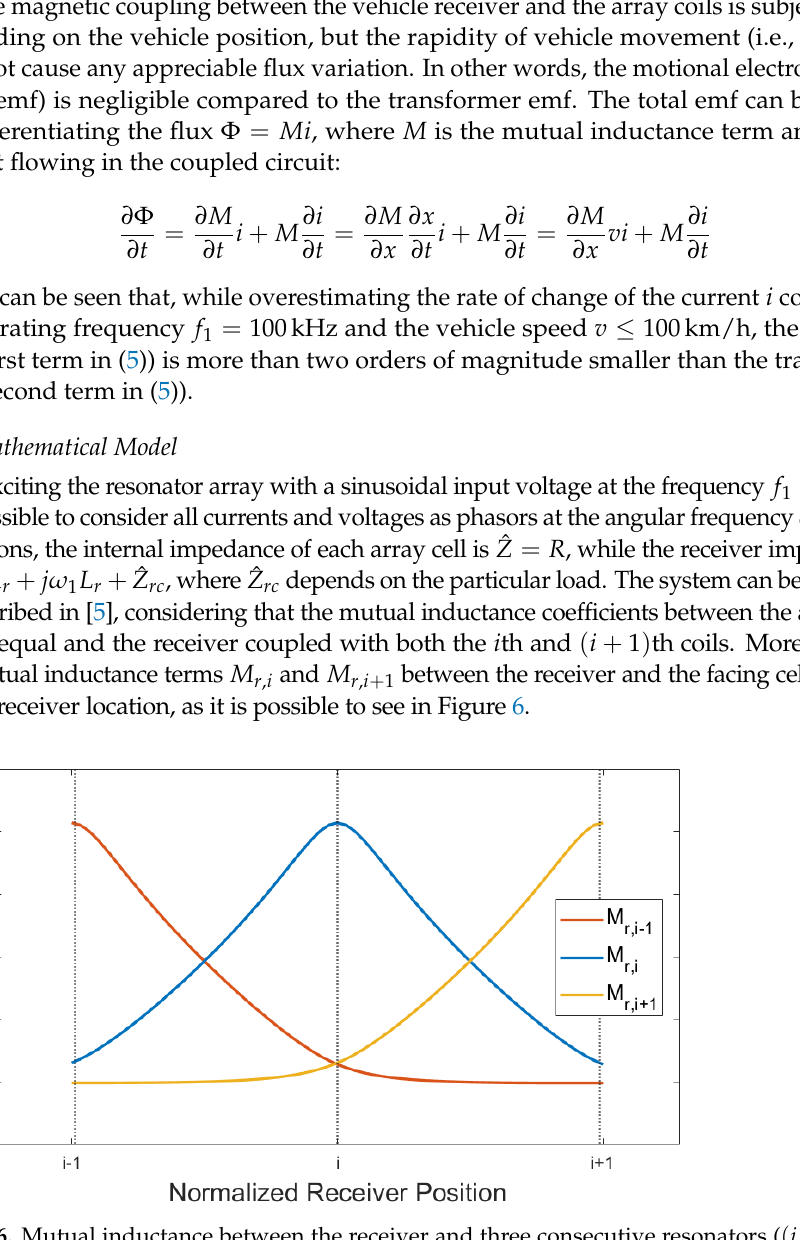
Figure 6. Mutual inductance between the receiver and three consecutive resonators ( ( i − 1 ) th, i th and ( i + 1 ) th) of the array, as a continuous function of the position x